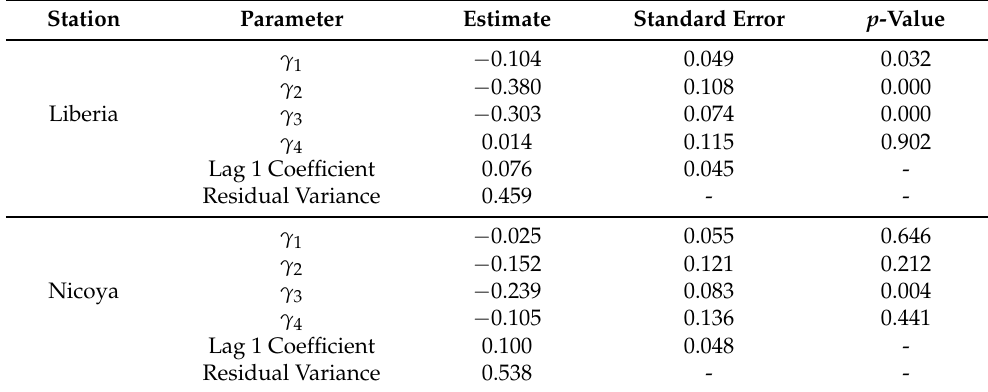
Table 2. Estimates and standard errors of some of the parameters of the regression model with AR(1)